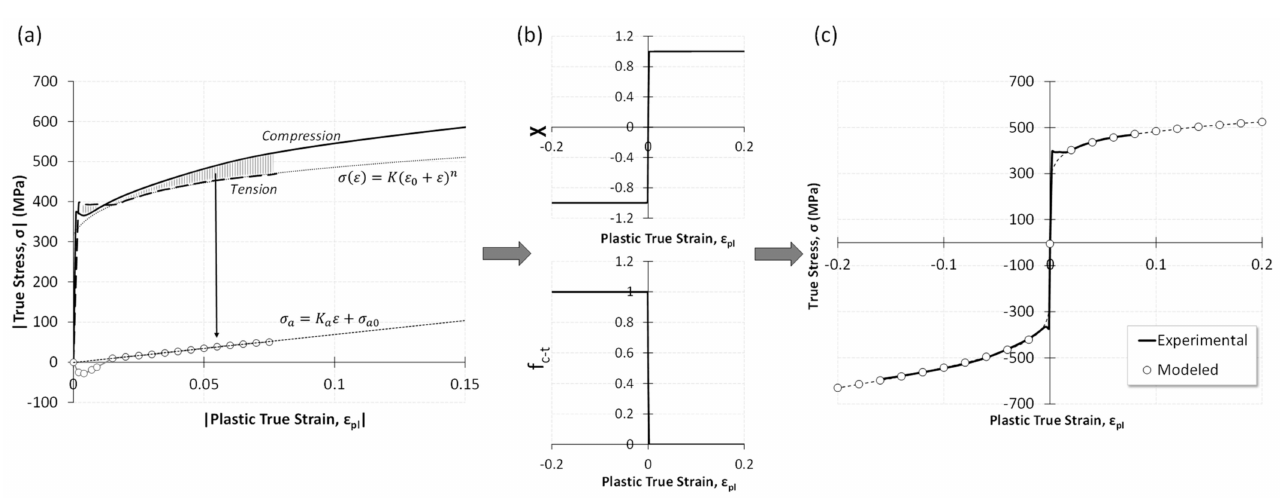
Figure 18. Tension–compression fitting by the modified Swift function, as shown in Equation (8). Case: Ticp2 90 ◦ 25 ◦ C 0.002 s − 1 . ( a ) Tension-Compression difference and fitting according to equation 3; ( b ) Definition of switching functions (Equations (4) and (5)); ( c ) Agreement between the proposed model (Equation (7)) and experimental